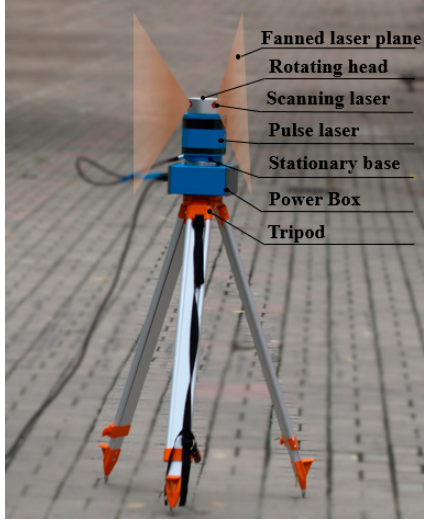
Figure 1. Image illustrating the design of a standard laser transmitter station.